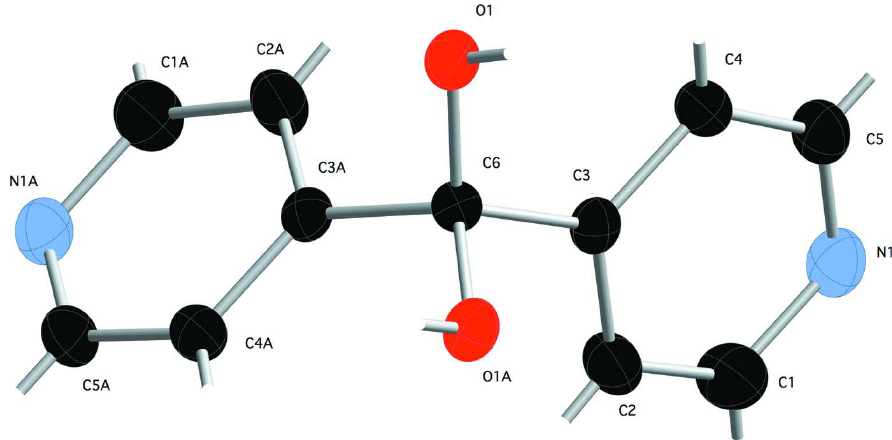
Figure 1 A complete molecule of the title compound. H atom positions are shown as gray sticks. Color code: C black, N blue, O red.